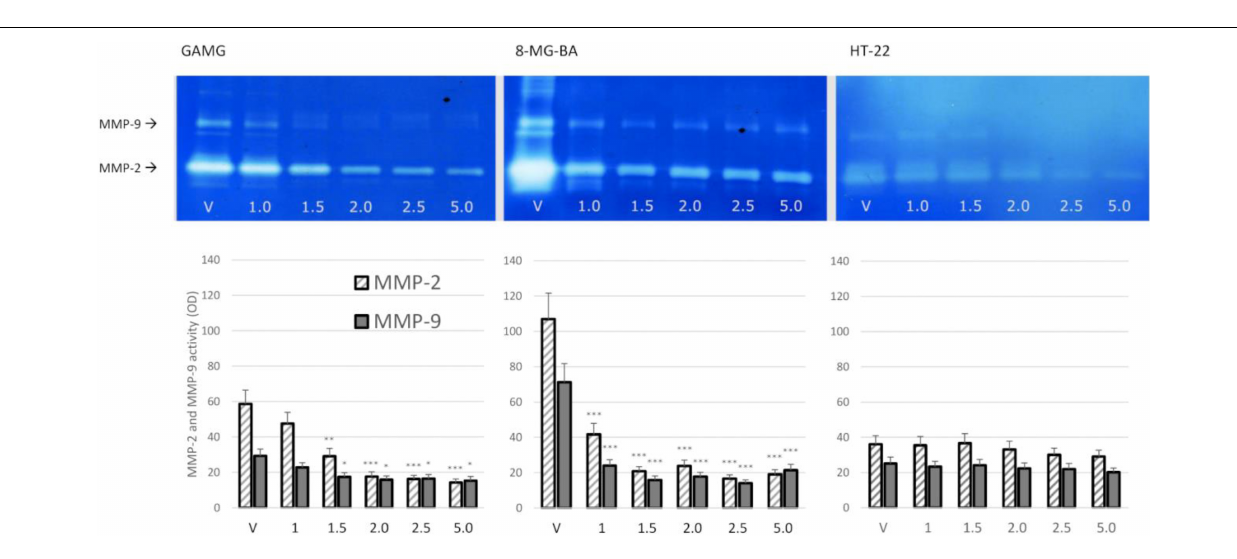
FIGURE 3 | BV effect on MMP-2 and MMP-9 secretion from GAMG, 8-MG-BA, and HT-22 cells. Significant decrease of gelatinase secretion was observed in GAMG and 8-MG-BA cells after 72 h of incubation with different concentrations of BV. The effect of BV on MMP-2 and MMP-9 secretion from HT-22 cells did